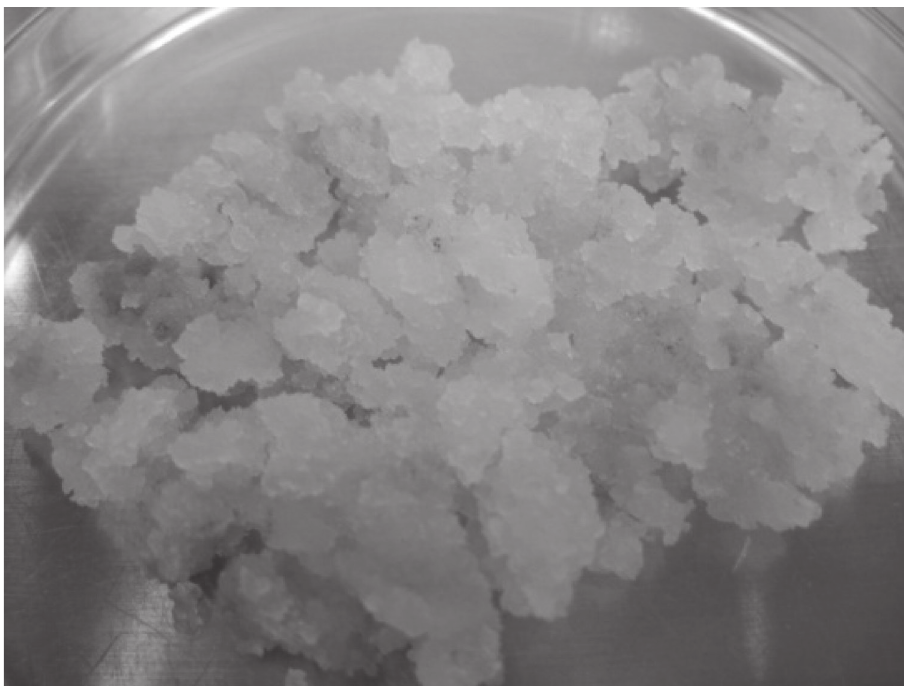
Figure 1 - Callus of Boerhavia paniculata Rich. from seed without coats in ½MS medium supplemented with 10% (v/v) coconut water and 1.5% of glucose and 2.265 μM of 2,4-D (w/v) sub-cultivated after 60